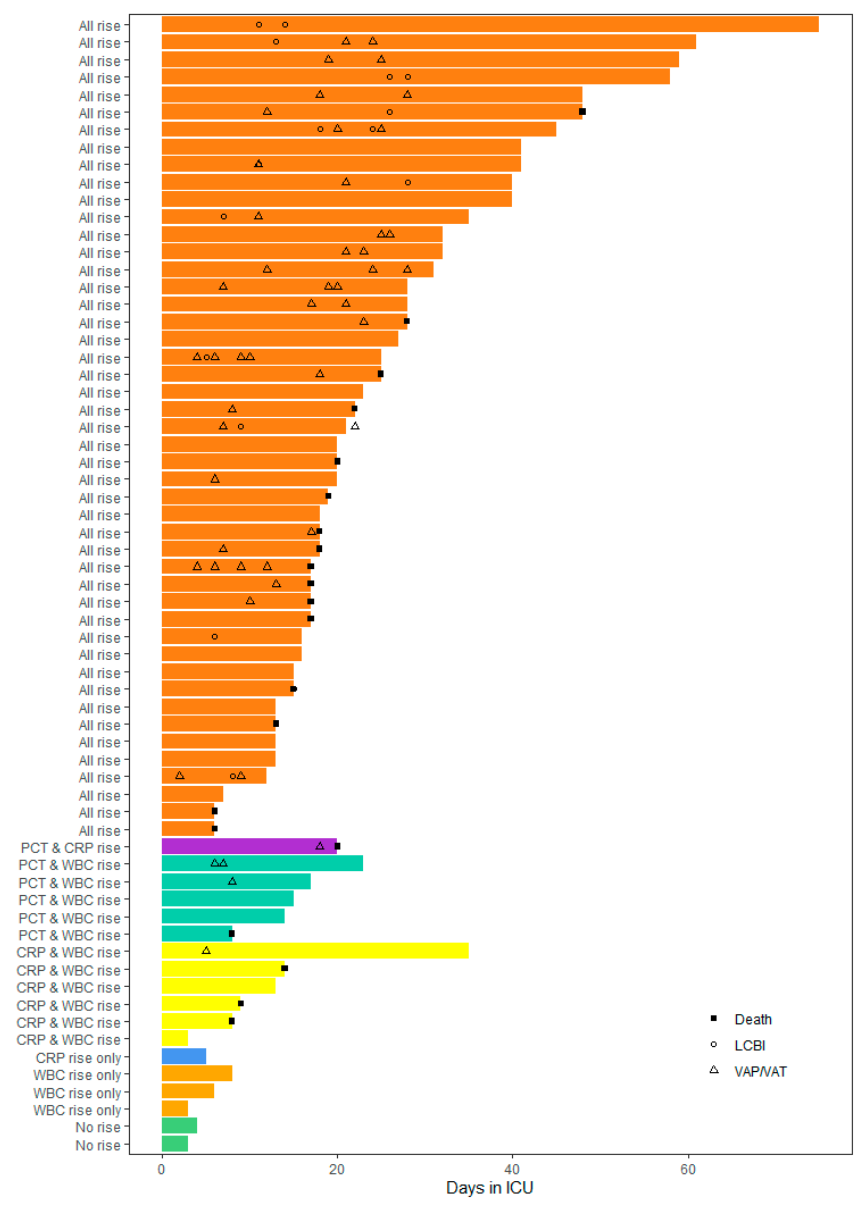
Figure 1. Changes in procalcitonin (PCT), C-reactive protein (CRP) and white blood cell count (WBC) with respect to the timing of confirmed ventilator-associated pneumonia/tracheobronchitis (VAP/VAT) ( ∆ ), laboratory-confirmed blood- stream infection (LCBI) (°) and death ( ■) on the ICU. A PCT rise was present in 97.0% of the patients with at least one confirmed VAP/VAT and/or LCBI event. CRP and WBC rises occurred in 93.9% and 97.0% of patients with con- firmed VAP/VAT and/or LCBI, respectively. Relative frequencies are detailed in Figure 2 and the individual patient heatmap is presented in Figure 3.